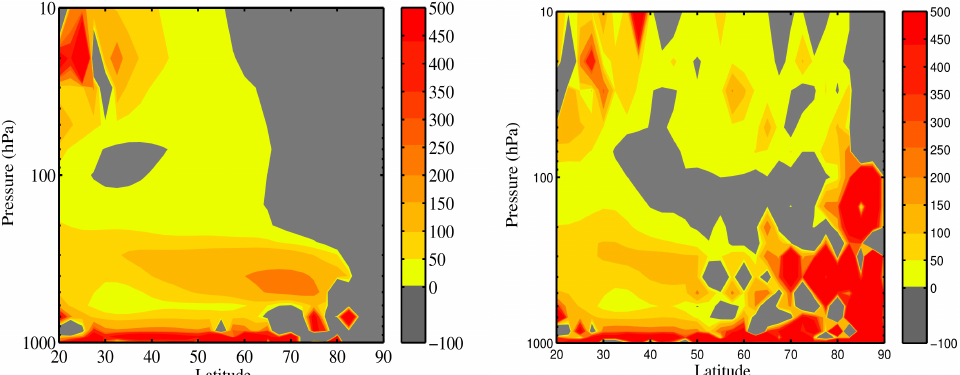
Figure A3. On the left the time-averaged zonal mean fields are used to calculate the vertical wave number squared (only for ( k,l) = ( 1 , 1 ) ). On the right the time mean of the vertical wave number is shown. It is clear that the vertical wave number derived from the time-averaged zonal mean fields has less noise than the time mean vertical wave number squared. We discuss this effect in more detail in the manuscript. Theoretically there are various ways in which one may reduce the level of noise in the time mean of the vertical wave number. The advantage of our proposed method is that it maps well and in a physical way on the list of criteria formulated in Table 1. Alternatively one can use other statistical methods like truncated means or trimmed means to reduce the